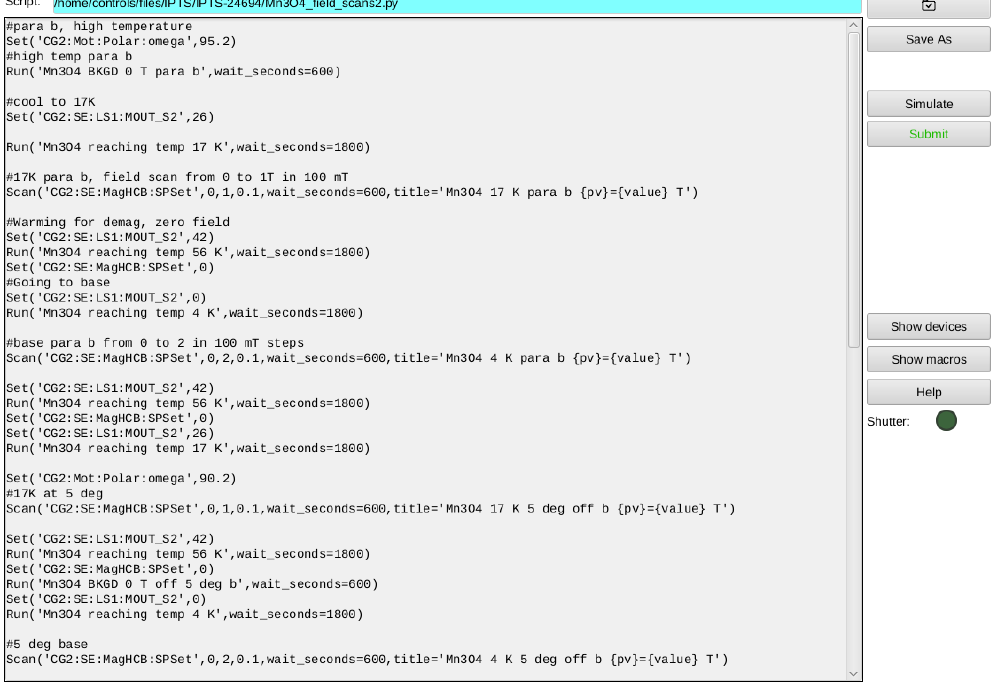
Figure 9. An example of the Python script used in Scripting Tool to control the magnet, cryostat temperature, and polarization for a highly flexible experiment.